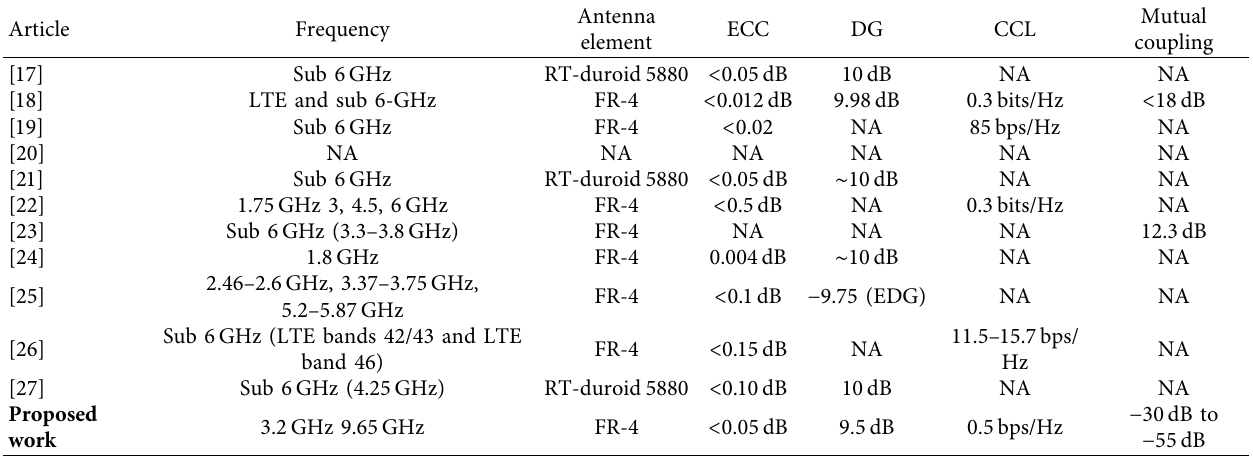
Table 5: Comparison of the previous works with proposed antenna in terms of MIMO